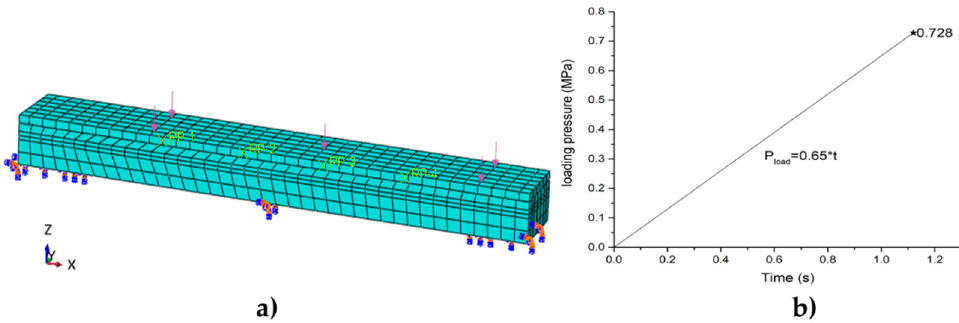
(14) Figure 9. The piezoelectric sensing system model.